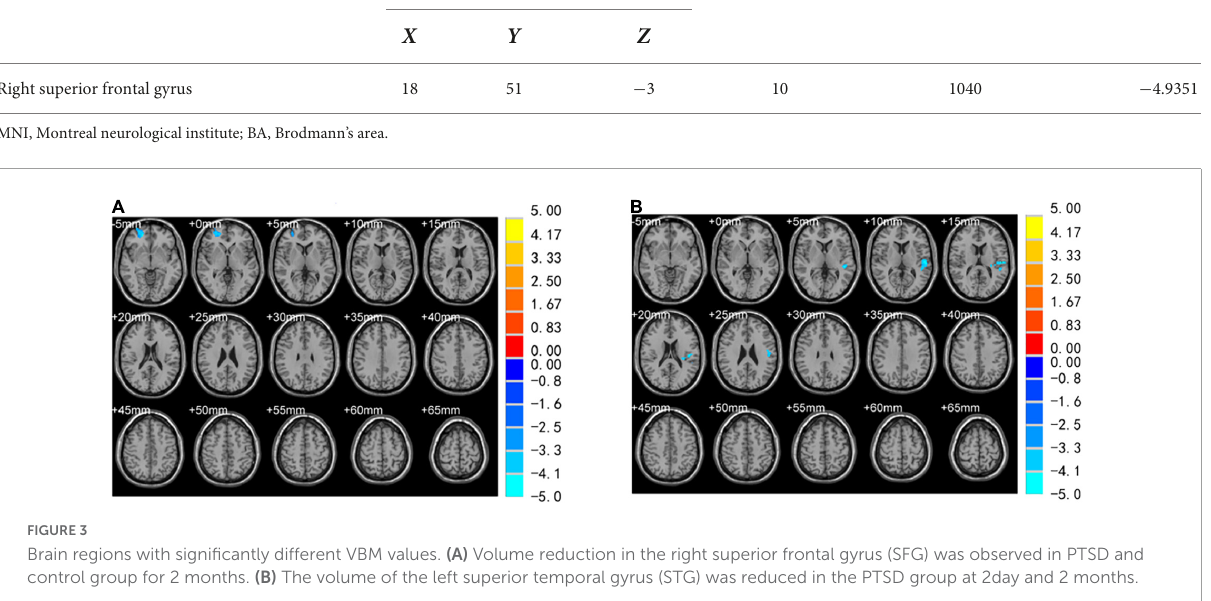
TABLE 2 Brain regions with significantly different VBM values of the PTSD group and the control group at 2 months. Brain regions of peak coordinates MNI coordinates